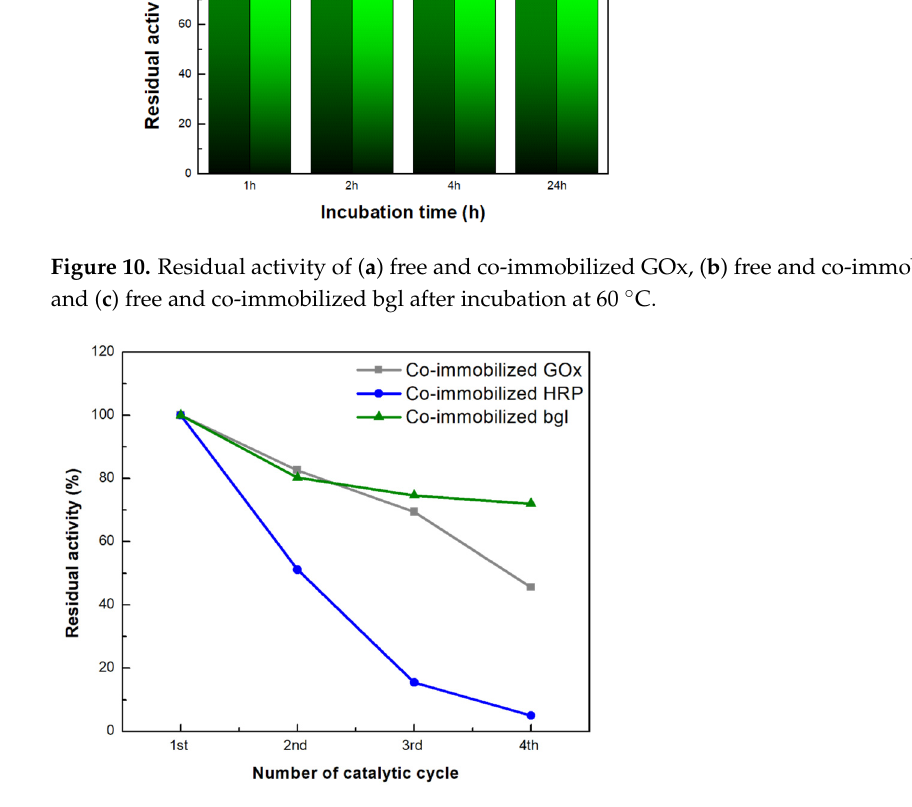
Figure 11. Reusability of the co-immobilized enzymes on bG for their respective substrates: residual activity as a function of number of cycles. The activity at the first catalytic cycle was set at 100% (error bars are too small to be